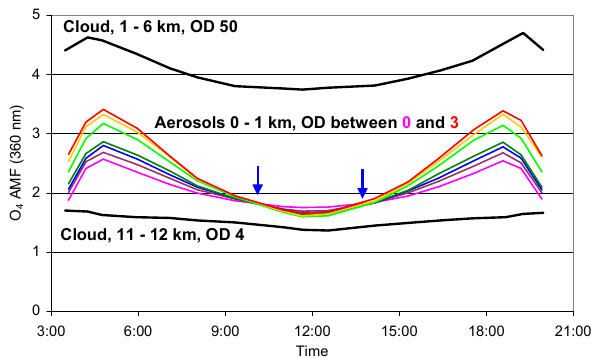
Figure 5. Simulated O 4 AMFs (360nm) for different aerosol and cloud scenarios. The violet and red lines indicate results for min- imum and maximum AOD of 0 and 3 respectively. For clear-sky conditions almost the same O 4 AMFs are obtained around SZA of 36 ◦ (indicated by the blue arrows), independent from the assumed AOD. Depending on the cloud OD and the cloud height, clouds can either increase or decrease the O 4 AMF compared to clear-sky con- ditions (Wagner et al., 2011). The simulations are performed for a day (26 June 2009) in the middle of the campaign.